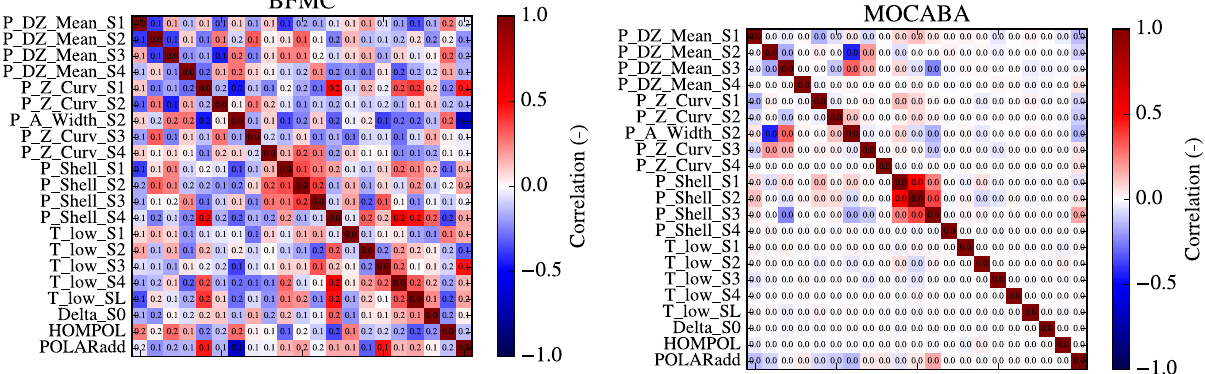
Fig. 5. Correlation matrices of the 21 posterior GEF-model parameters. Each correlation coefficient has its 95%-bootstrap- confidence interval over-laid on